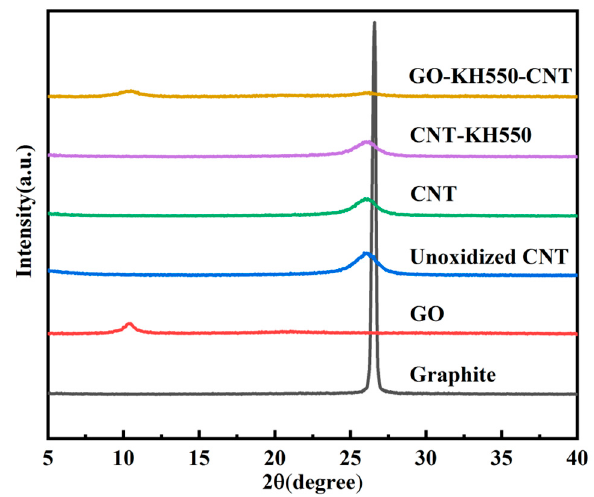
Figure 5. XRD patterns of Graphite, GO, unoxidized CNT, CNT, CNT-KH550 and GO-CNT.